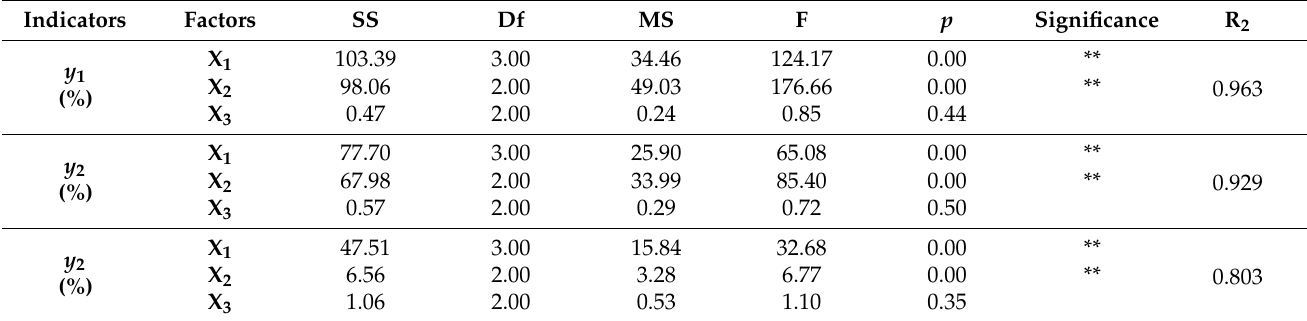
Table 4. Univariate analysis of variance.